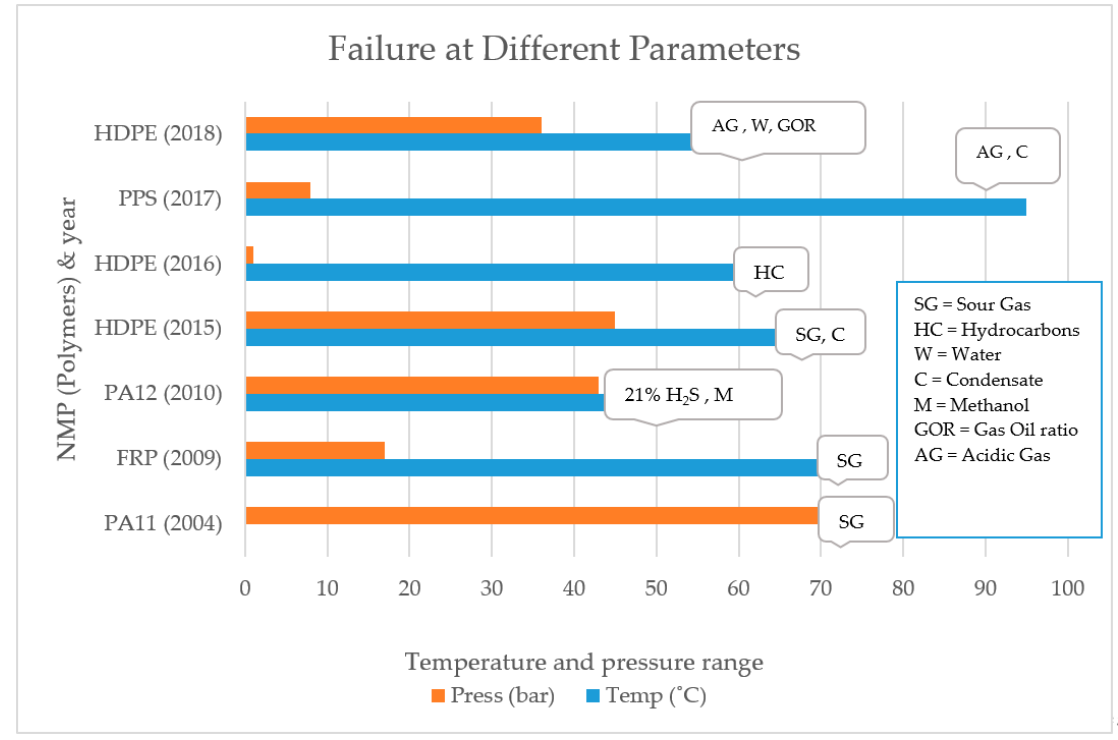
Figure 7. Polymer Liner failures in previous years.